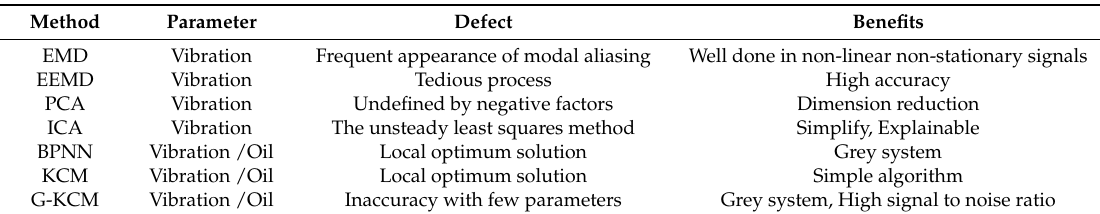
Figure 22. ( a ) 3-Clustering results of oil parameters within 128 h based on G-KCM; ( b ) 3-Clustering results of oil parameters within 128 h based on KCM; ( c ) 3-Clustering results of oil parameters except temperature within 128 h based on G-KCM; ( d ) 3-Clustering results of oil parameters except temperature within 128 h based on KCM. Table 8. The comparison of performance of each